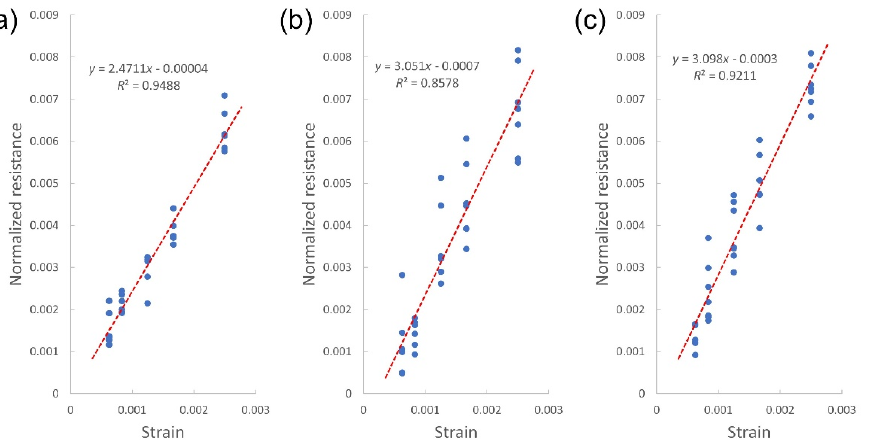
Figure 7. Gauge factor as a function of the number of stacked layers of printed strain-gauge patterns: ( a ) 2.471 for a single layer, ( b ) 3.051 for three layers and ( c ) 3.098 for five layers.